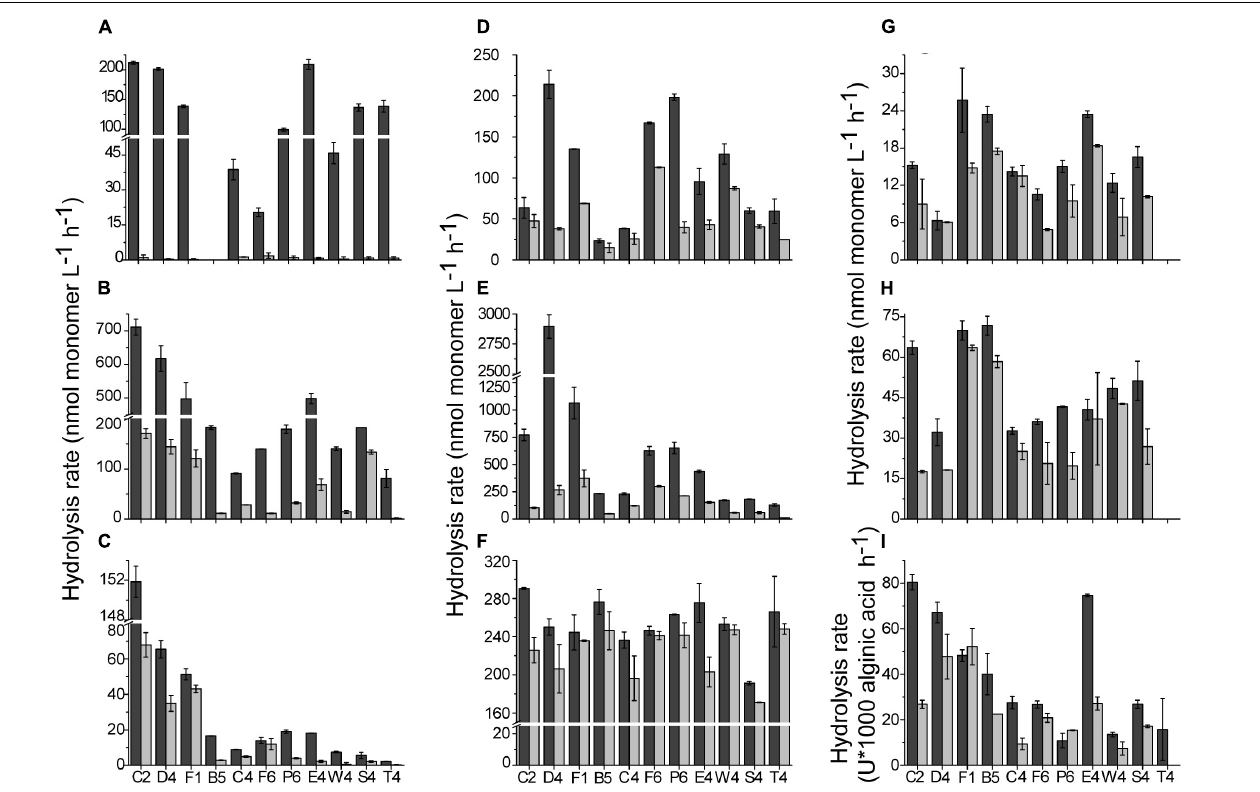
FIGURE 2 | The hydrolysis rates of tested substrates at 35 ◦ C. (A) α -D-glucopyranoside (AG). (B) β -D-glucopyranoside (BG). (C) N-acetyl- β -D-glucopyranoside (NAG). (D) Laurate (C12). (E) Phosphate disodium salt hexahydrate (PDSH). (F) Casein. (G) Chitin. (H) Carboxymethyl cellulose (CMC). (I) Alginic acid. Values are the mean hydrolysis rate in unfiltered water (dark gray), and 0.22- µ m filtered water (light gray) at each station.